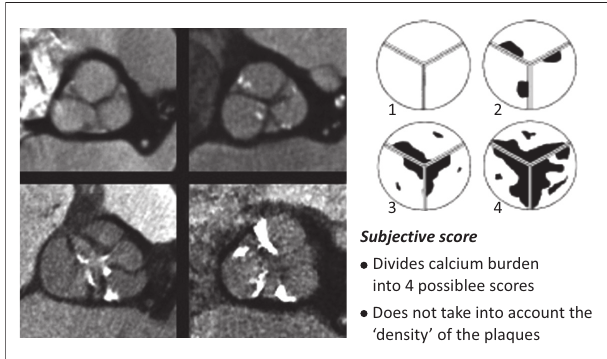
FIGURE 3: Rosenhek score.